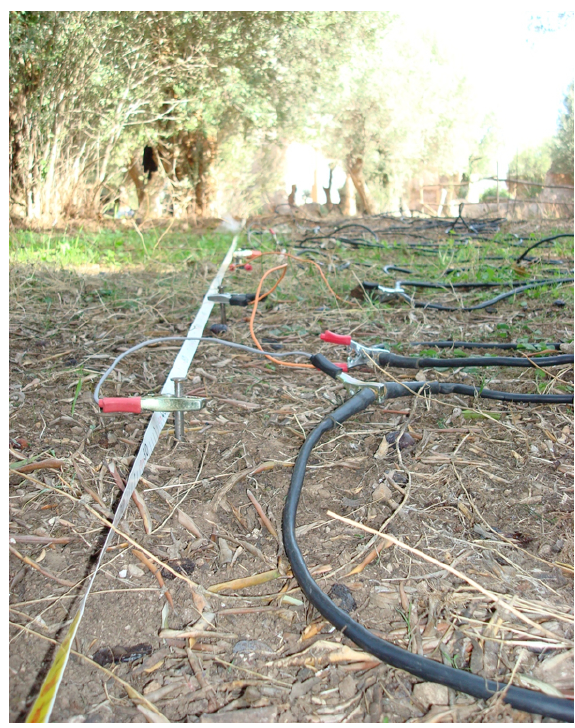
Fig. 9. Detail of the electrodes used in our survey (photo A. M.